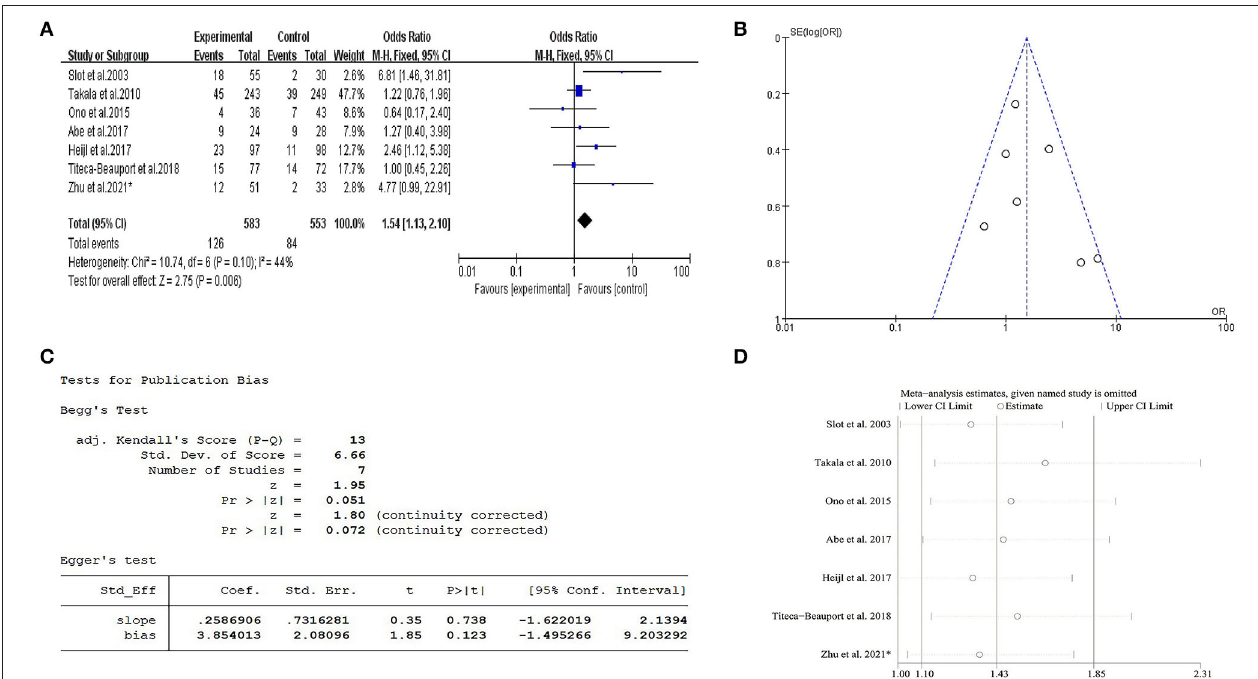
FIGURE 3 | Meta-analysis about gender vs. 1-year mortality in AAV. (A) The forest map showed male was a risk factor for 1-year mortality of patients with AAV with OR value of 1.54 (95% CI: 1.13- − 2.10; P = 0.006) and no significant heterogeneity ( I 2 = 44%, P = 0.1). (B) Funnel plot indicated there was no publication bias. (C) Egger test also indicated no publication bias ( P > 0.05). (D) Sensitivity analysis indicated that there was no significant change in the overall effect magnitude after removal of either study, and the results were robust and reliable. * Data of our single-center retrospective